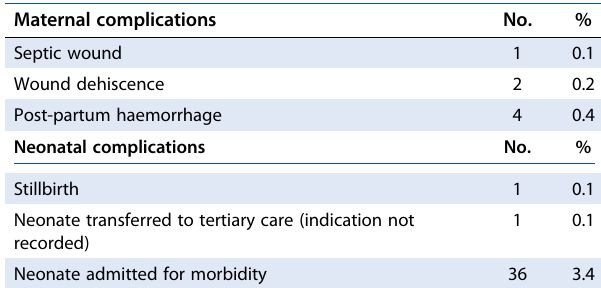
Table 4: Maternal and neonatal complications post CS Maternal complications